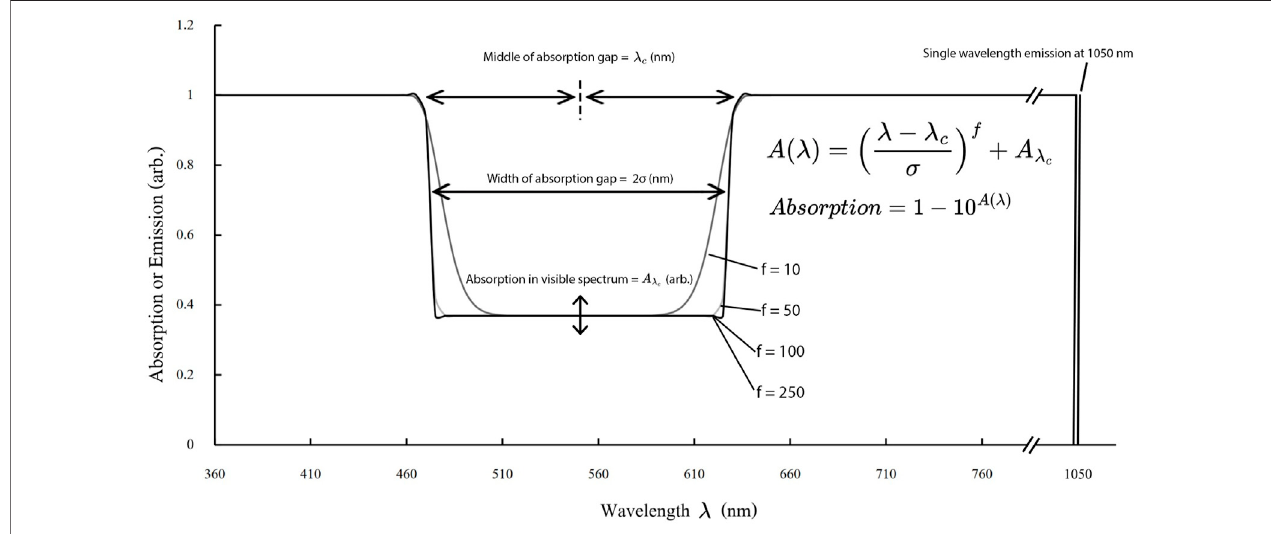
FIGURE 3 | Showing the relationship between λ c , σ and A λ